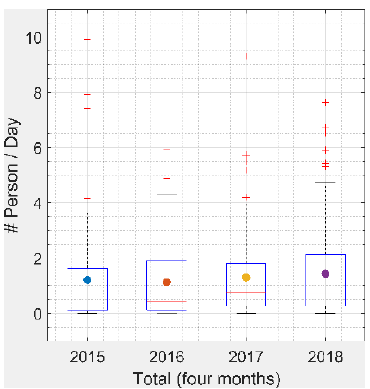
Figure 7. Estimated daily asthma-related ER visits in Georgia due to prescribed fires for the first four months of 2015–2018. The central mark indicates the median, the point indicates the mean, and the bottom and top edges of the box indicate the 25th and 75th percentiles, respectively. The whiskers bound the range of values, excluding the outliers.